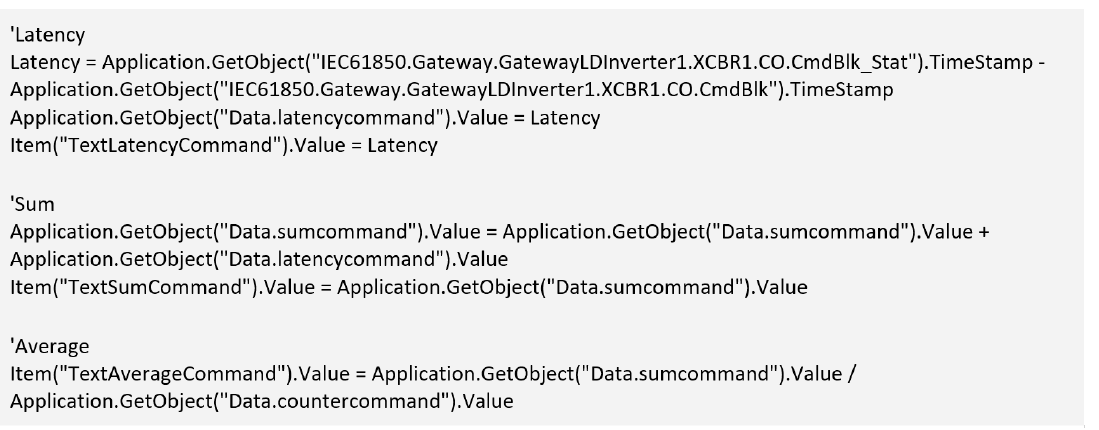
Figure 18. Latency calculation for report.